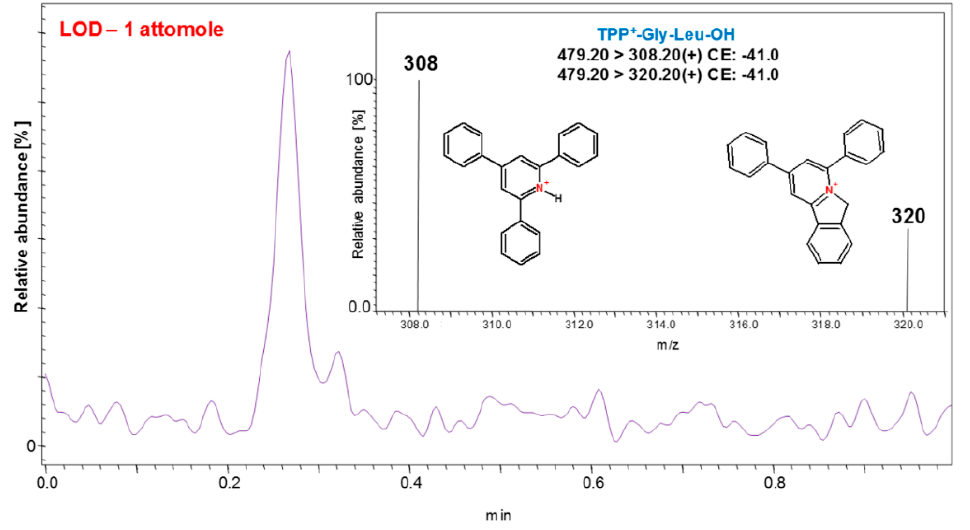
Figure 13. ESI-MS-MRM chromatogram obtained for H-Gly-Leu-OH derivatized with 2,4,6- triphenylpyrylium salt and registered for 1 attomole [66].